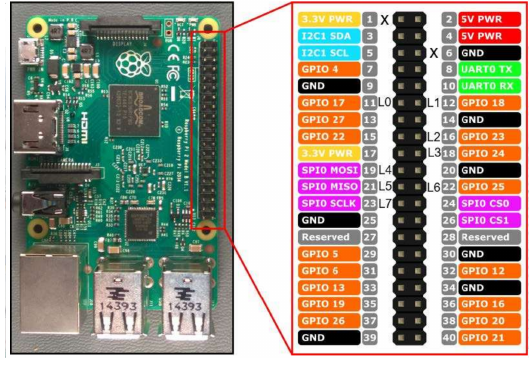
Figure 6. Raspberry Pi used pins scheme. Table 15. Pins, attached devices and associated actions/states for the Raspberry Pi